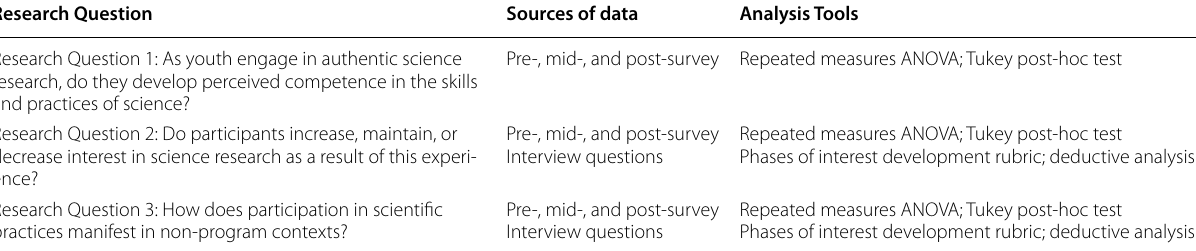
Table 3 Research questions, sources of data, and analysis tools Research Question